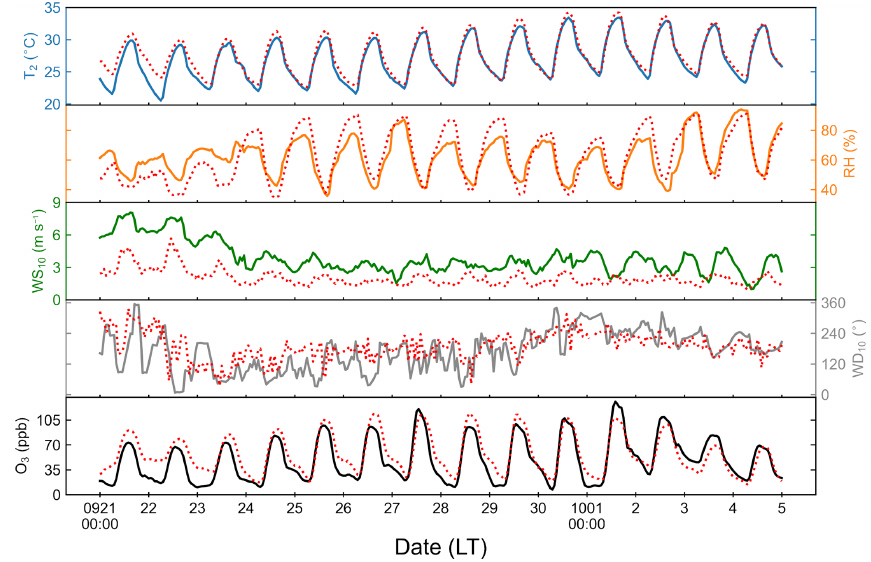
Figure 5. Hourly variations in T 2 , RH, WS 10 , WD 10 , and O 3 in observed values (red dots) compared to model simulations (solid lines) from 21 September to 4 October 2019. Table 2. Statistical metrics of meteorological parameters and O 3 in the comparison between the observations (Obs.) and simulations (Sim.) from 21 September to 4 October. Obs.